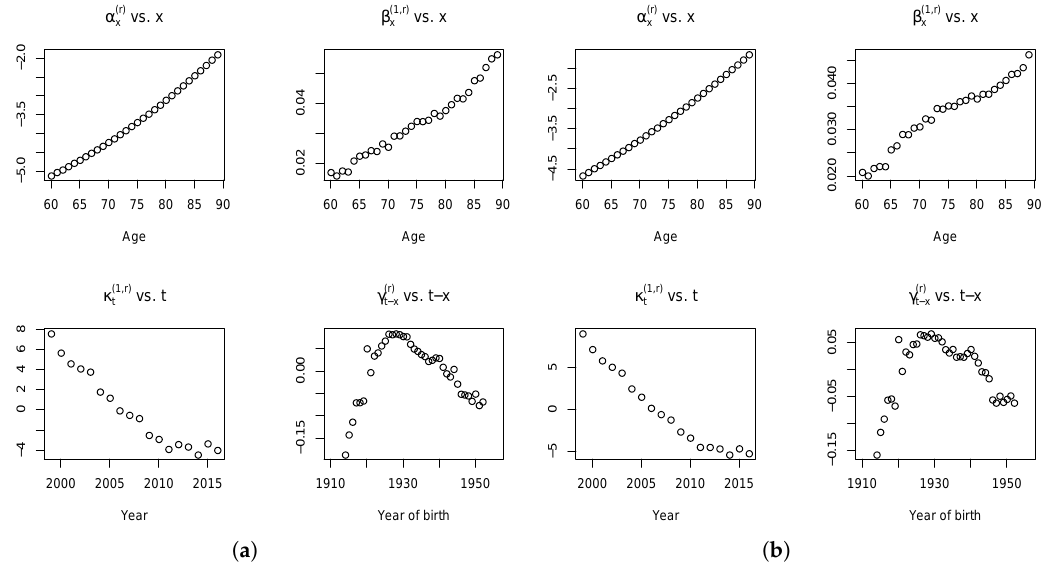
Figure 5. Estimated trend parameters of the RH model for ( a ) UK females and ( b ) UK males.